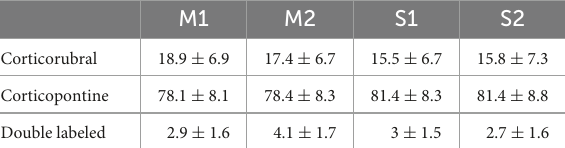
TABLE 1 Percentage of CR and CP neurons in sensorimotor